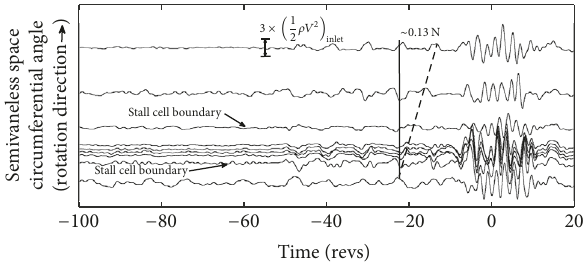
Figure 12: Unsteady pressure traces at 80% speed with 60 kg/h steam injection (Kulite transducers all located in a semivaneless